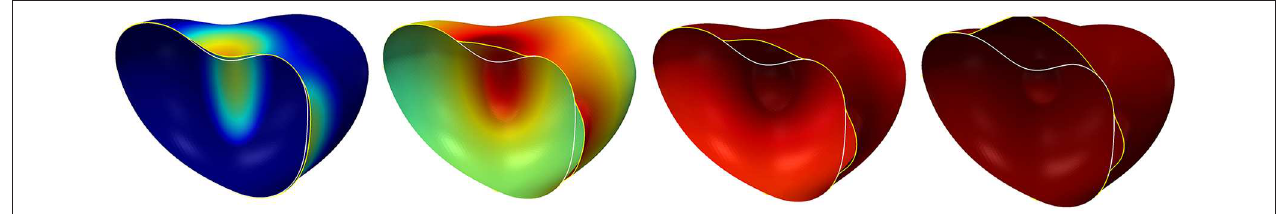
FIGURE 10 | Surface evolution at time t 0.25,1.25,2.5,10 for the model in section 5.5 with the parameters given in Table 3 . The diffusion of the signal is a uniform = constant. The color from blue via green and yellow to red corresponds to the signal strength: Dark red indicates c > c B , i.e., regions where the linkers (if not broken yet) are maximally strengthened by the signal c , dark blue indicates c < c b and thus regions where the linker strength is not altered by c .